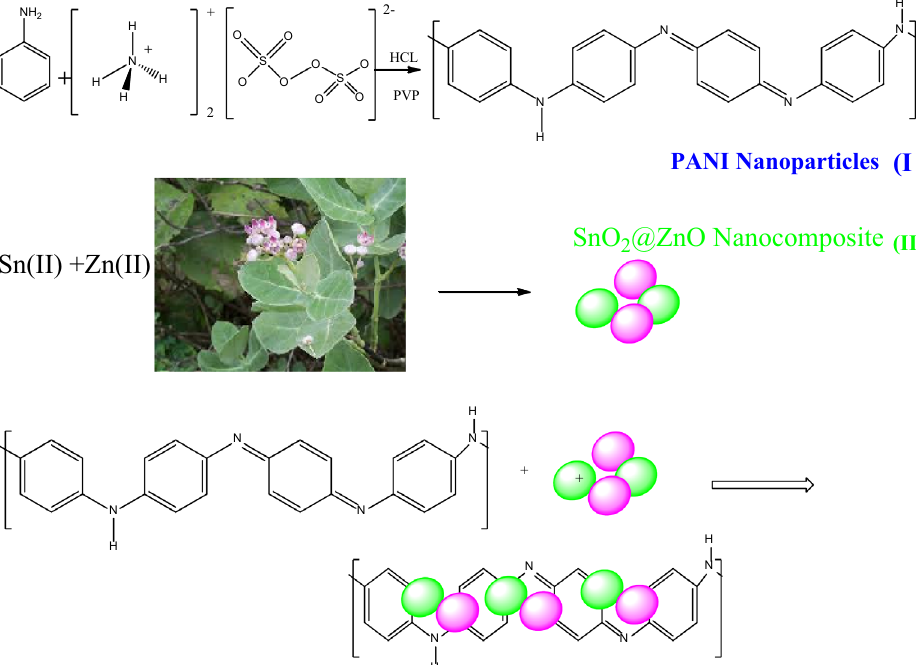
Figure 1. The green synthesis procedure of SnO 2 @ZnO.PANI